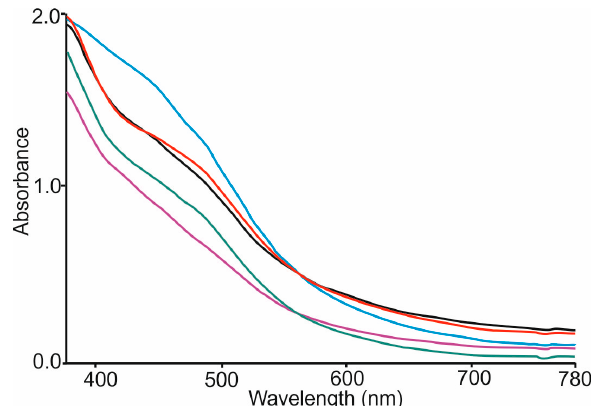
Figure 2. UV-vis spectrum of liqueurs made with different varieties of apple. Samples: Ligol (black), Kosztela (red), Grey Reinette (blue), Rubin (green), Cox Orange (purple). The results of CIELab parameters were also used to calculate chroma C* (which reflects to color saturation), h* (Color hue angle) and browning index (BI). This parameter is usually used as an indicator of the browning extent in food products containing sugar. C*, h* and BI values showed by the beverage made from Cox Orange were clearly different from the rest and indicated that this nalewka did not have an intensive color. Nalewka s made from Grey Reinette appeared as the darkest and most intensive colored sample. Table 2. CIELab color parameters of liqueurs made from different varieties of apples.